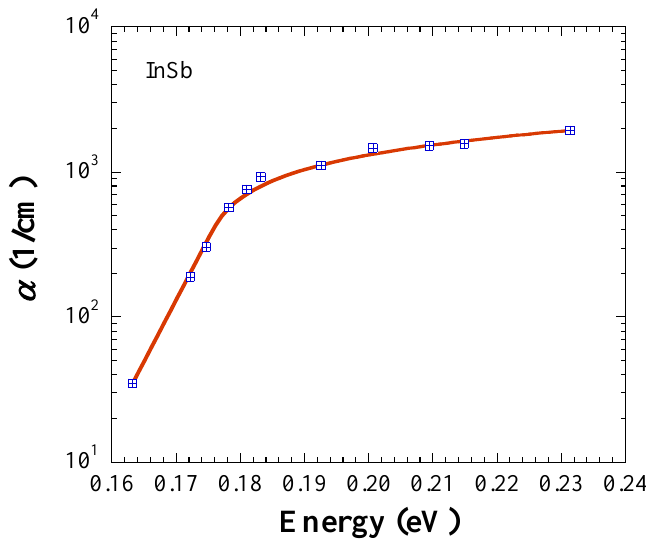
Figure 2. Absorption coefficient of InAs. The symbols are retrieved from Ref. [8], and the solid line represents the fit with Equations (5) and (6).